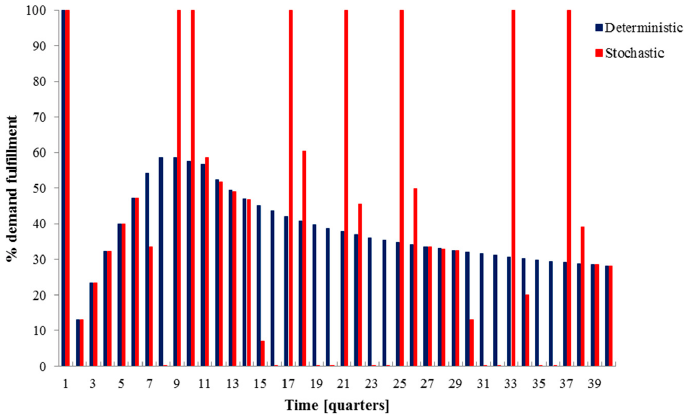
Figure 12. Variation of % of demand fulfilment for NGL for deterministic and stochastic cases.